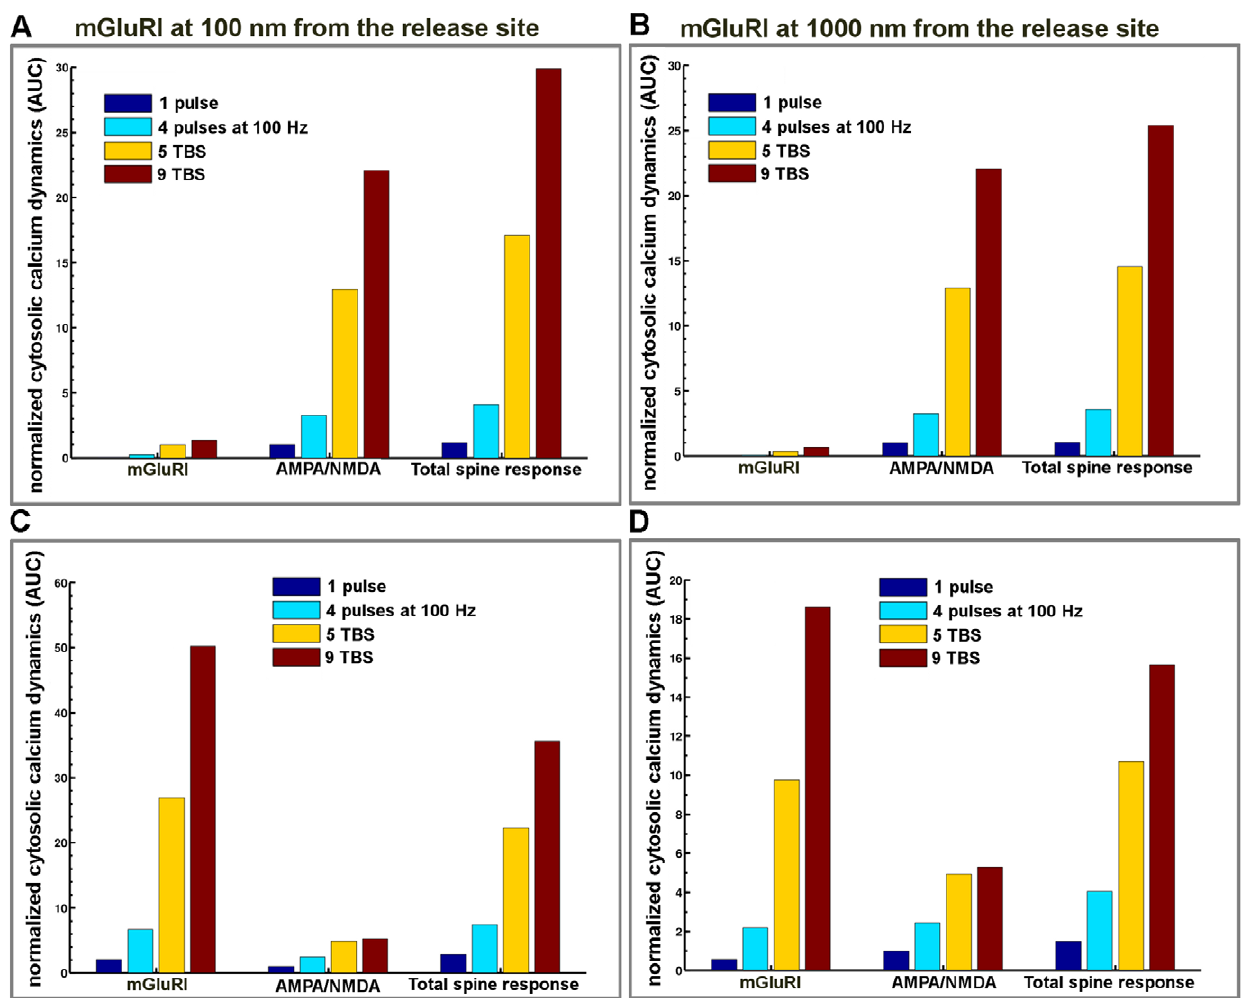
Figure 11. Interactions between ionotropic and metabotropic glutamate receptors in glutamate-mediated calcium and IP3 transients in dendritic spines. (A, B) Histograms represent the AUC for calcium dynamics generated by activation of mGluRI, ionotropic glutamate receptors (AMPA/NMDA), and all receptors combined (total spine response) with mGluRI located at 100 nm (A) or 1000 nm (B) from the release site following various stimulation patterns. Note the small, but significant supra-additive effect of the combined activation of all the receptors on calcium dynamics. (C, D) Corresponding histograms of the quantification of the AUC for IP3 dynamics generated by activation of mGluRI, ionotropic glutamate receptors (AMPA/NMDA), and all receptors combined (total spine response). Note the inhibitory effect of the activation of AMPA/NMDA receptors on the total response to glutamate stimulation, especially at high stimulation frequency. In all cases, AUC values were normalized to the AUC value calculated for one release event.